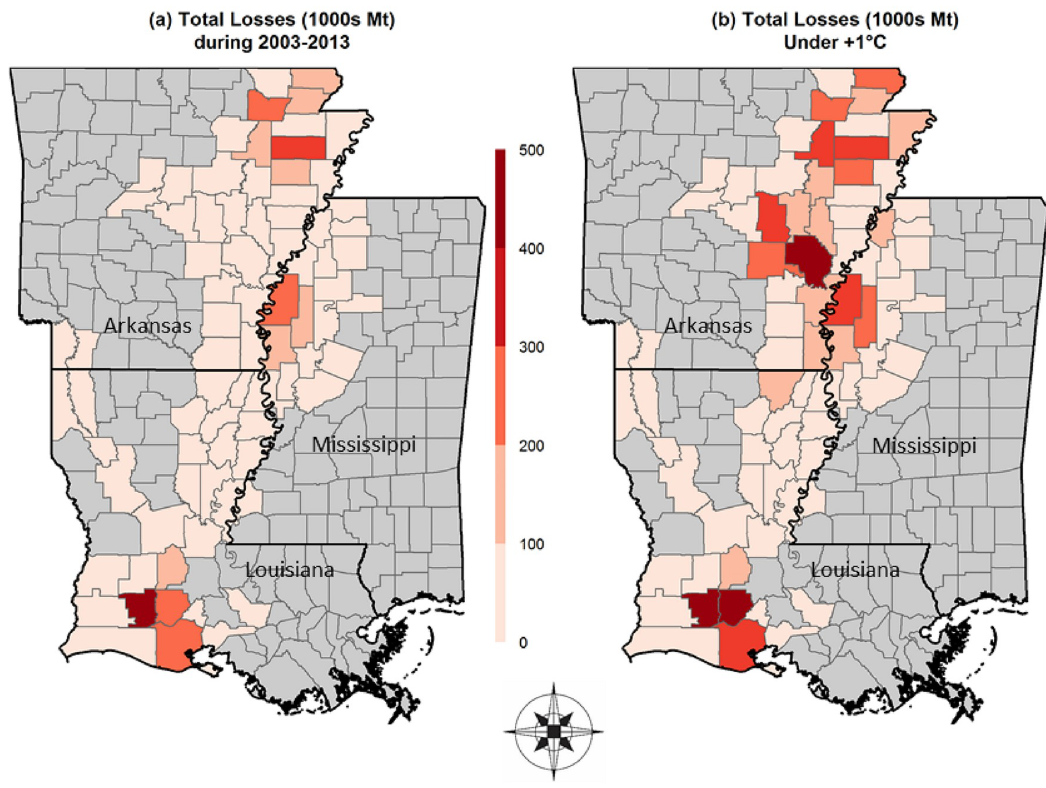
Fig 1. County-level rice production losses to Bacterial Panicle Blight (BPB) in Arkansas, Louisiana, and